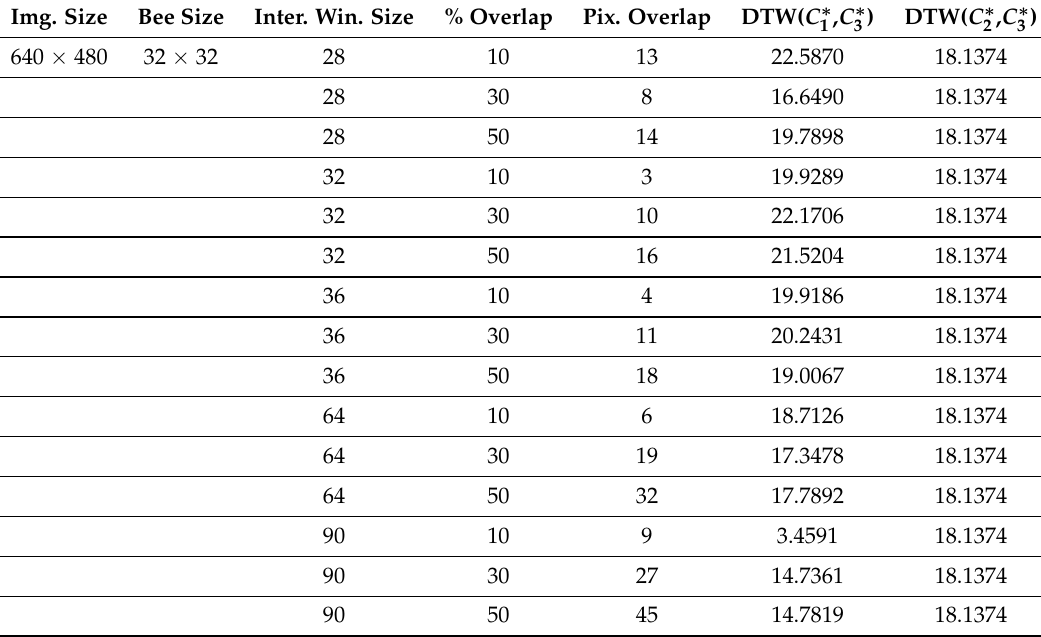
Table A6. DTW values for LT _ Vid . mp 4 with image size of 640 × 480; C ∗ and C ∗ is Human Count (ground 3